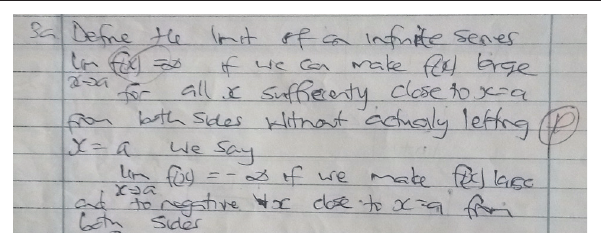
FIGURE 1: Written response of ST20 to task 1a. An example of a response of a student who operated at N level.